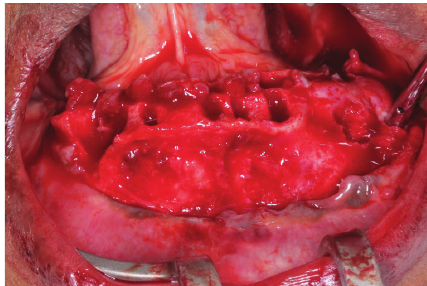
Figure 6: Suturing of the surgical site.